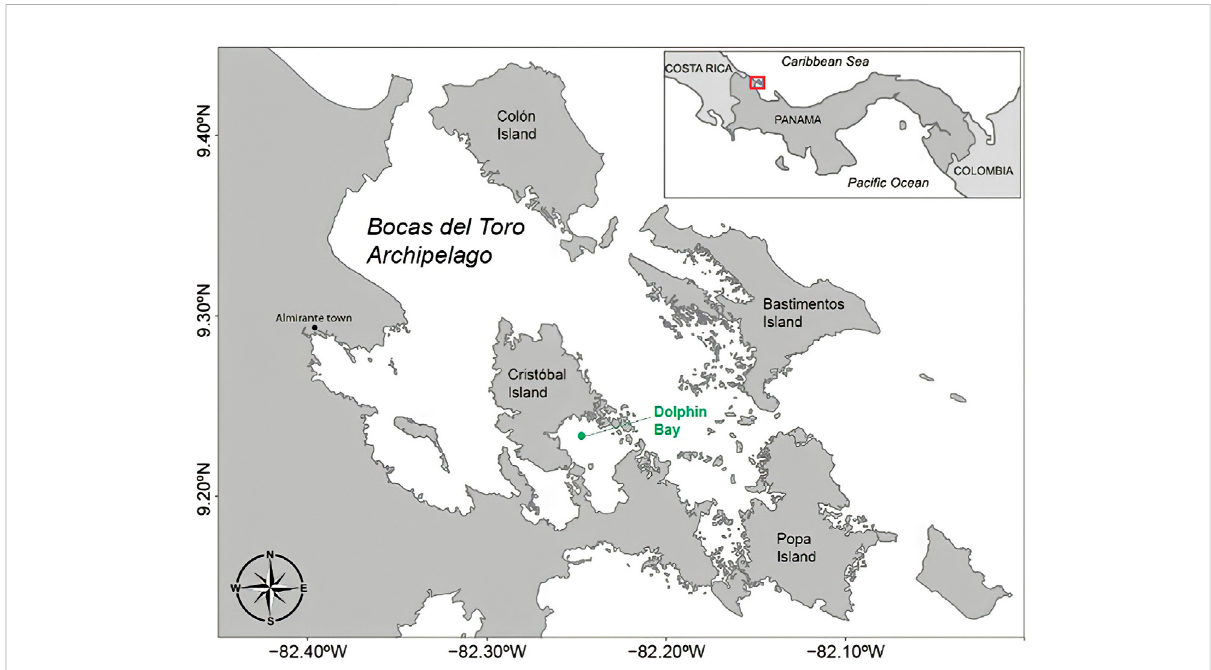
FIGURE 1 ArchipelagoofBocasdelToro,Panamá.ThegreendotshowsthelocationwithinDolphinBaywheretheautonomousrecordersweredeployed during pre-lockdown and lockdown periods (latitude and longitude in decimal